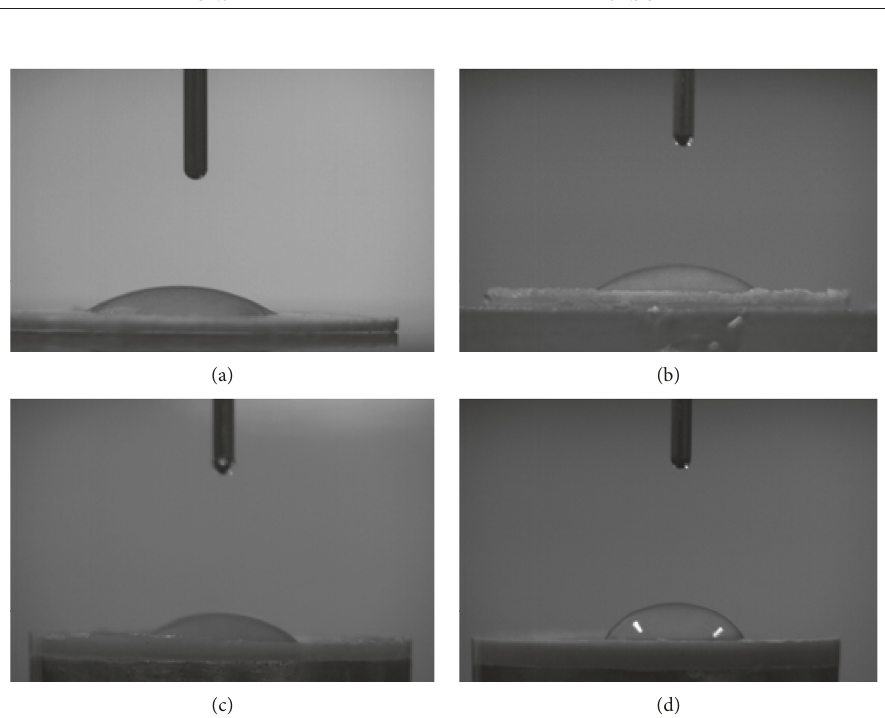
Figure 3: Contact angle analysis of MMT and C 16 mim-MMT. (a) MMT; (b) 0%; (c) 10%; (d)